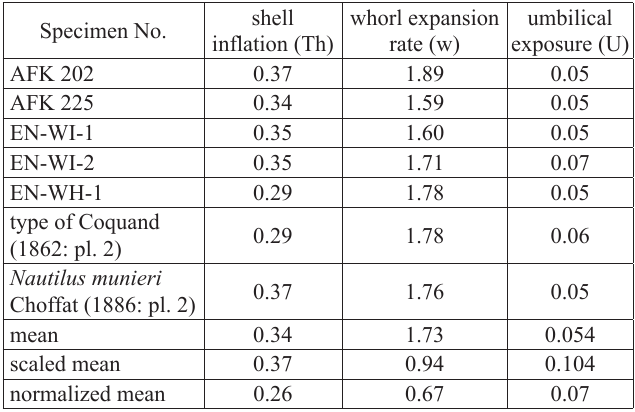
Table 2. Raw values of shell inflation (thickness ratio; Th = Wb/D max ), whorl expansion rate (w = Wh/Wh at -180°) and umbilical exposure U (= width of umbilicus in % of D max ) of Angulithes mermeti (Coquand, 1862) for illustration in Westermann morphospace (Fig. 8A); see Ta- ble 1 for initial measurements and Ritterbush and Bottjer (2012) and Yacobucci (2018) for methodology. Abbreviations: D max , maximum diameter; U, size of umbilicus at D max ; Wb, whorl breadth at D max ; Wh, whorl height at D max